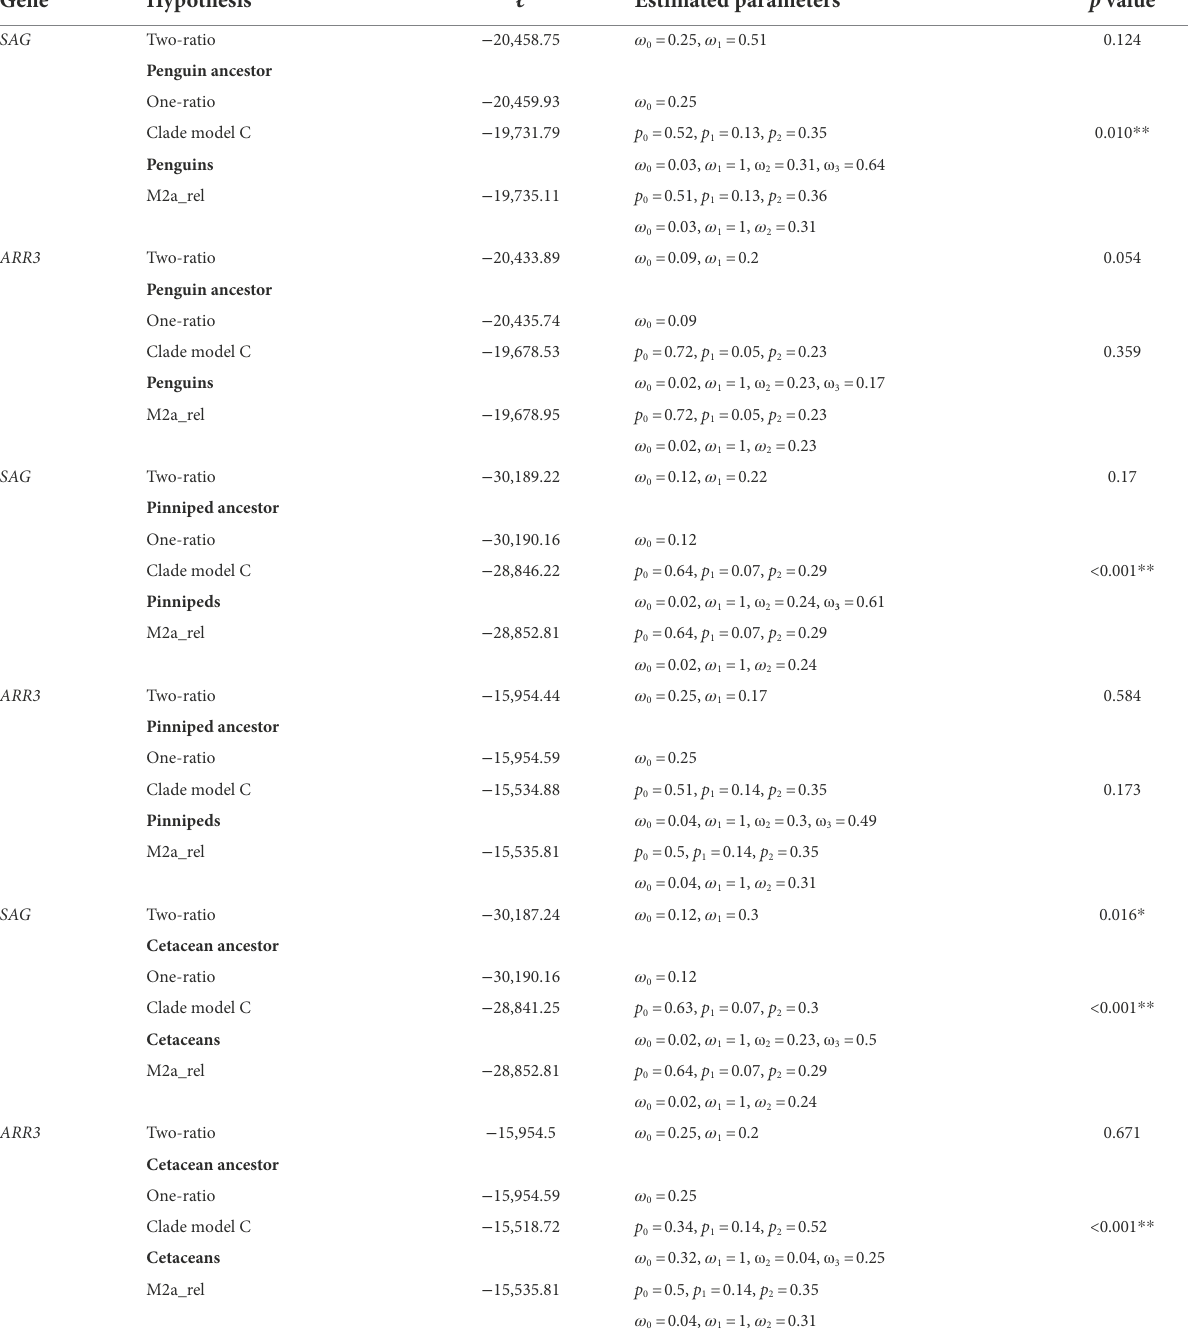
TABLE 1 Tests for selection on SAG and ARR3 genes in deep-diving